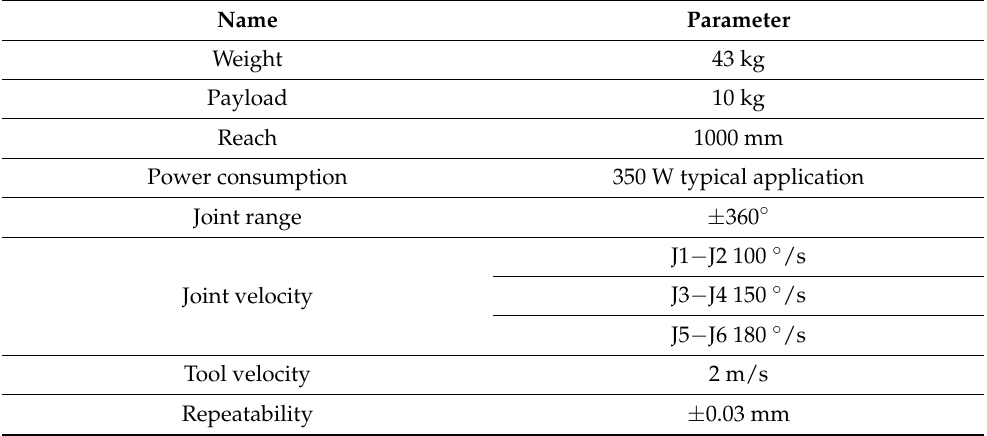
Table 2. Technical parameters of PIONEER TP300 series of cable probe.